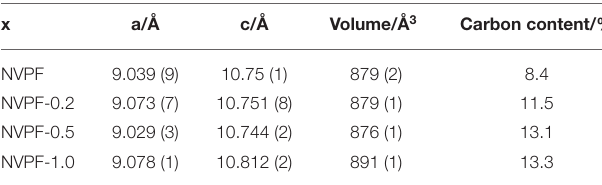
TABLE 1 | Cell parameters in the P4 2 /mnm space group for the C@Na 3 V 2 (PO 4 ) 2 F 3 samples.